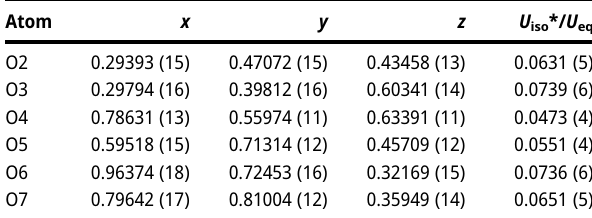
Table  : Fractional atomic coordinates and isotropic or equivalent isotropic displacement parameters (Å 